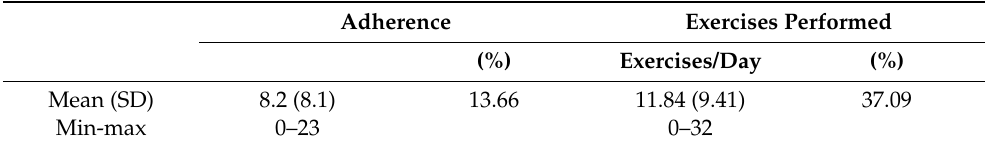
Table 5. Telerehabilitation app adherence. Adherence Exercises